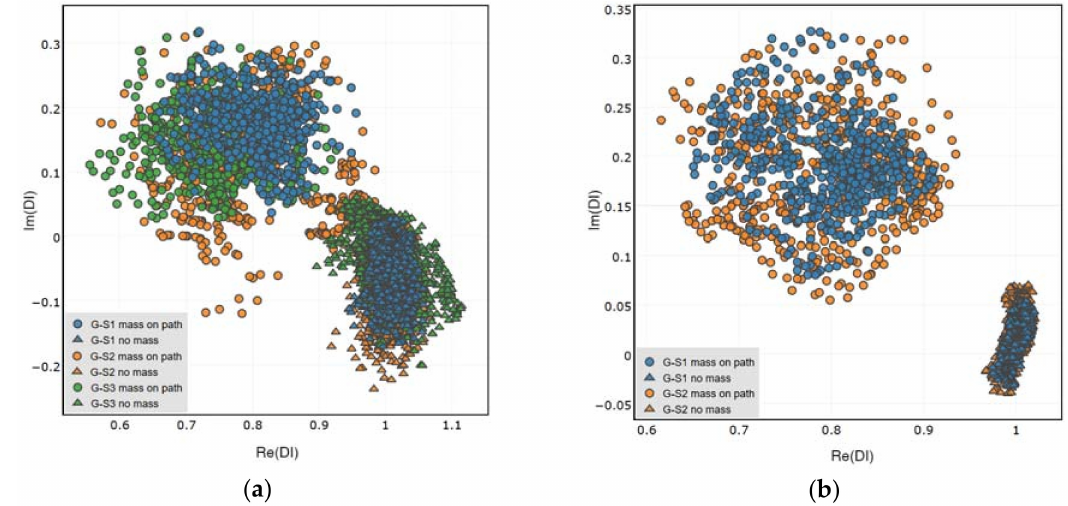
Figure 15. Comparison of DIs obtained for the pristine state of the structure and for simulated damage presence: ( a ) Attached network; ( b ) Embedded network.